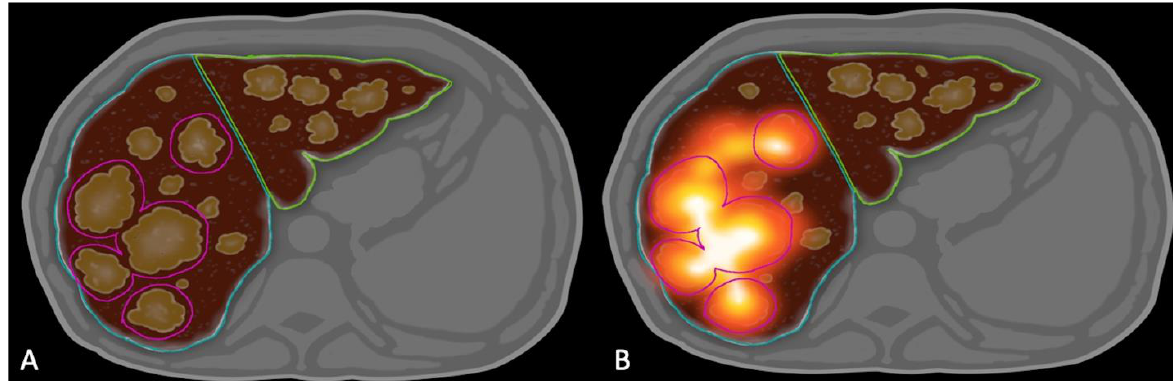
Figure 8. Dosimetry Method Diagram. ( A ) contour the target lobe and 5 largest tumors on the target lobe. ( B ) Bremsstrahlung SPECT/CT showing the cumulative activity in the 5 and 5 largest tumors in the target lobe.